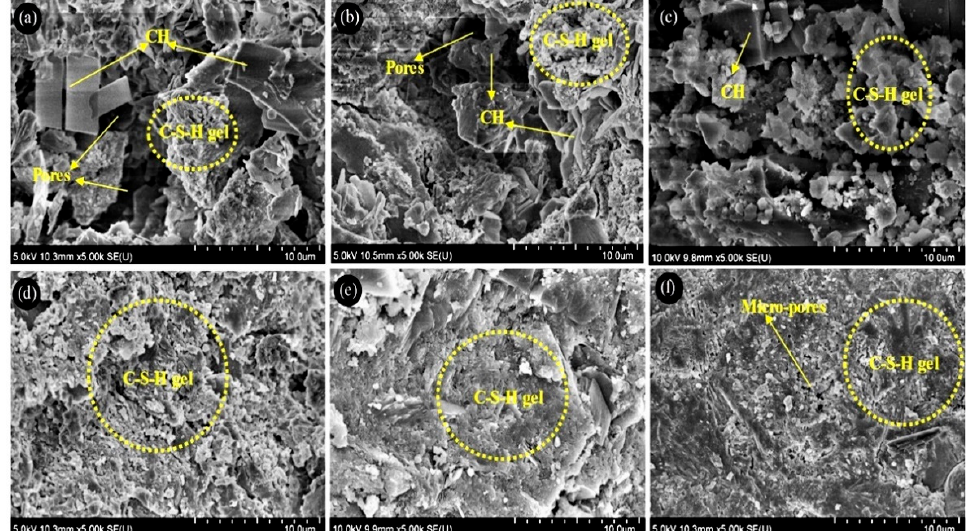
Figure 11. SEM images of mortar specimens cured for 28 days. ( a ) Control mix, ( b ) OPC/TW50-1, ( c ) OPC/P50-1, ( d ) SF-10, ( e ) SF-10/TW50-1 and ( f ) SF-10/P50-1. ( c ) OPC / P50-1, ( d ) SF-10, ( e ) SF-10 / TW50-1 and ( f ) SF-10 /